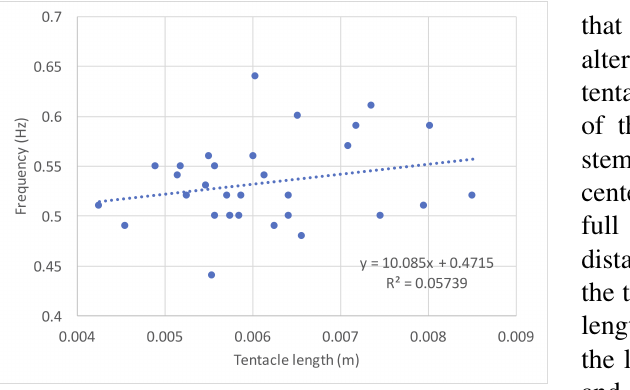
Fig. 2: Pulsing frequency vs. tentacle length for 15 corals in the field (Red Sea, Eilat, Israel) and 15 cultured corals in the lab. There is not a significant relationship between pulsing frequency and size.